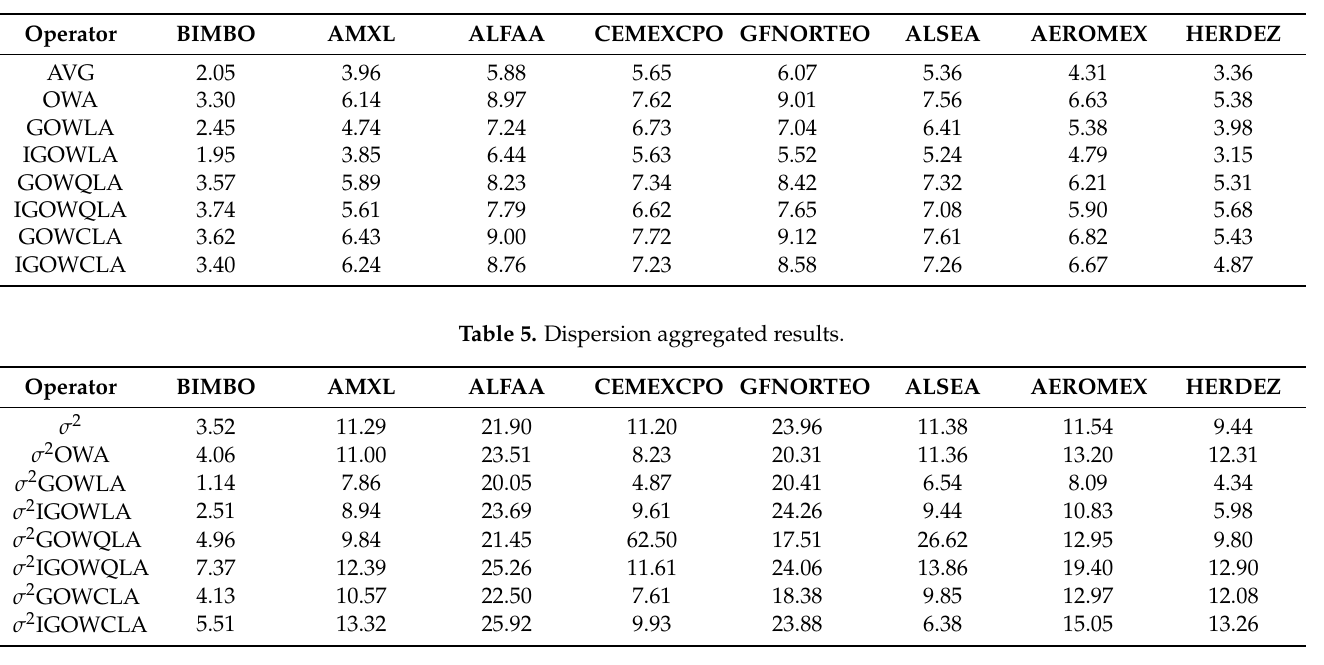
Table 4. Payoff aggregated results.